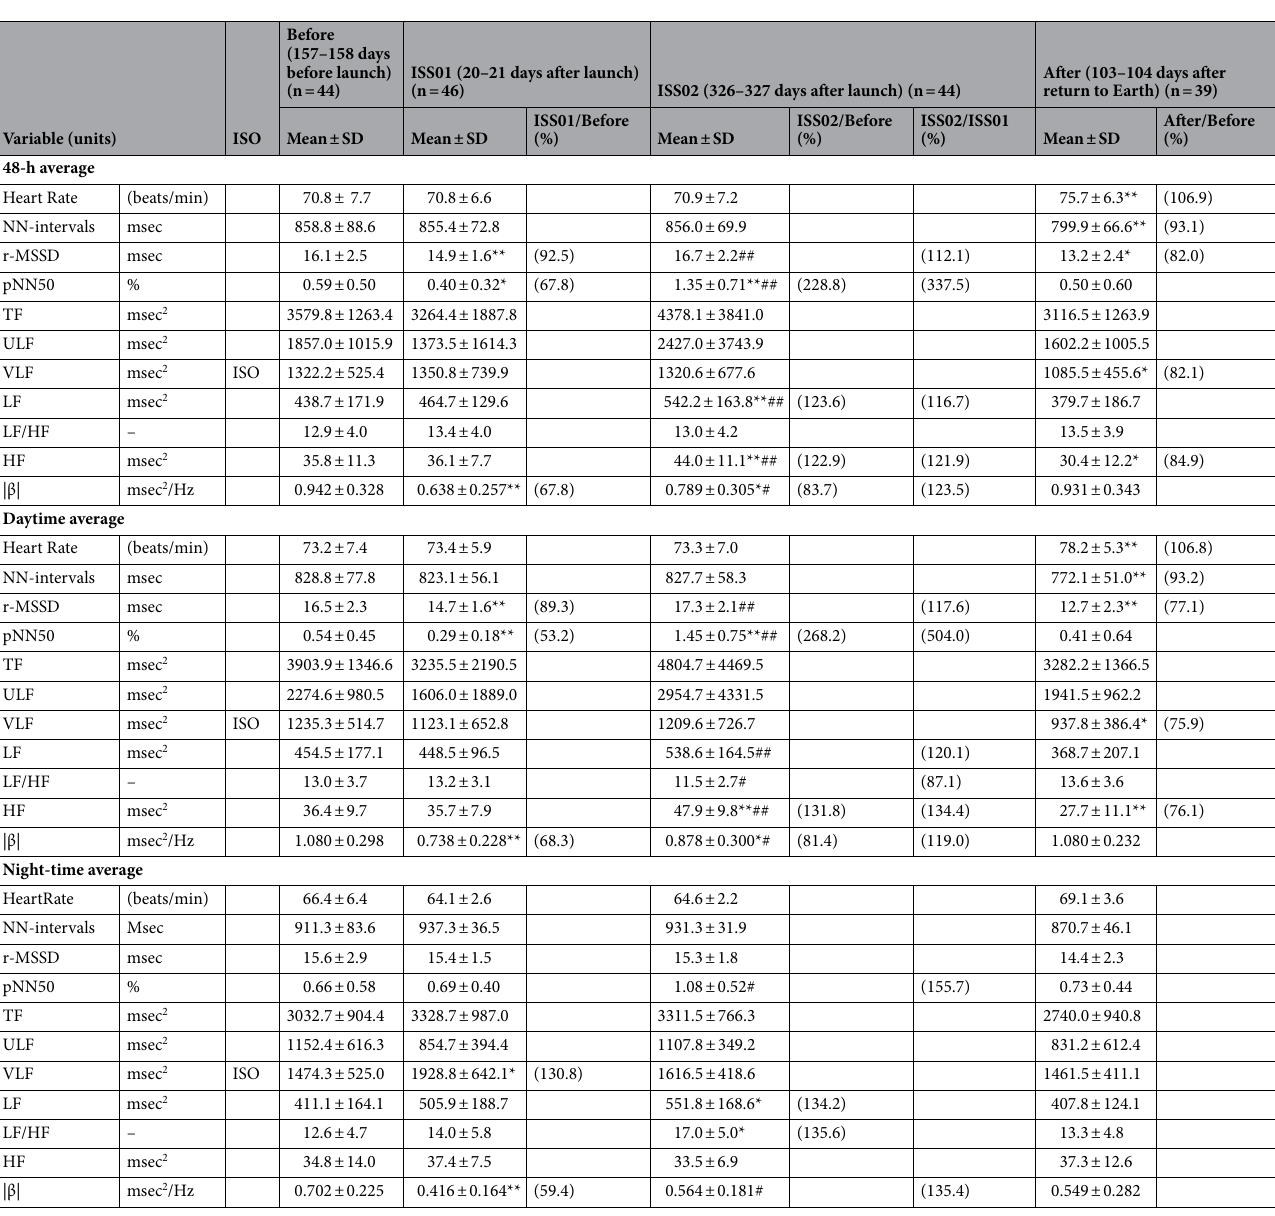
Table 1. Change in 48-h average of heart rate and heart rate variability during 12-month spaceflight ‡. ISO: Infraslow Oscillation (0.01–0.10 Hz). TF: (0.0001–0.5) Hz; ULF: (0.0001–0.003) Hz; VLF: (0.003–0.04) Hz; LF: (0.04–0.15) Hz; HF: (0.15–0.40) Hz; β: (0.00013–0.02) Hz. |β|: slope of fractal scaling, corresponding to periods of 120 to 0.83 min, reflecting the intrinsic autonomic regulatory system. ‡ Tests applied to hourly averages of 5-min intervals in order to eliminate or at least reduce serial correlation. *P < 0.05; **P < 0.01: ISS01, ISS02 or After vs.Before ; #P < 0.05; ##P < 0.01: ISS02 vs. ISS01. P-values from Student t-test; SD = standard deviation. n: number of hourly averages (of 5-min